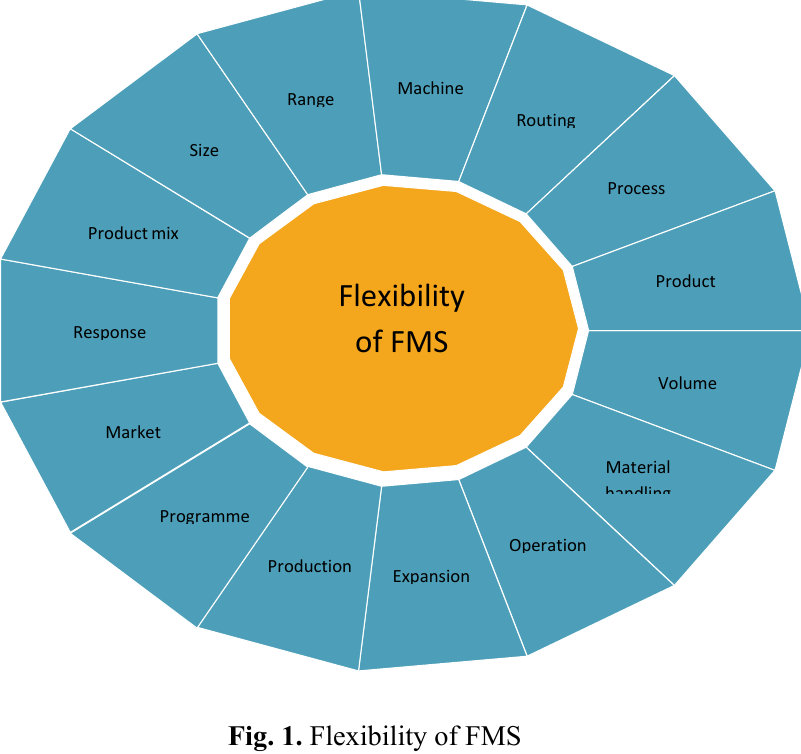
Fig. 1. Flexibility of